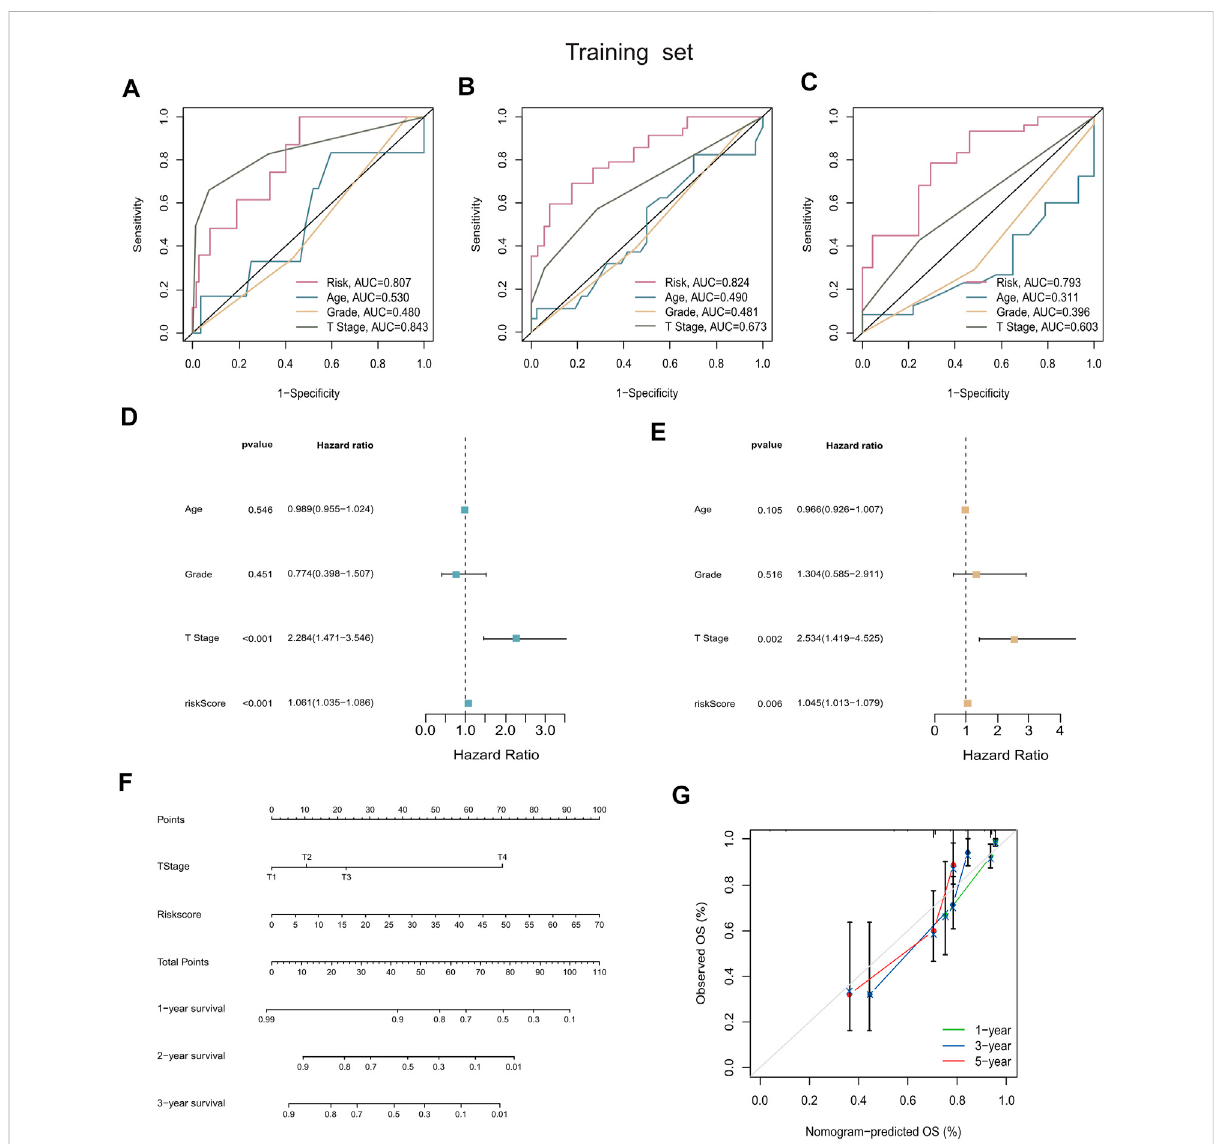
FIGURE 5 Construction and validation of the prognostic nomogram. (A – C) AUC values of nomogram points at 1-year, 3-years, and 5-years were compared with other clinical parameters, including age, grade, stage, and T stage. (D,E) Forest plots summarizing the results of univariate and multivariate Cox analyses of risk scores and clinicopathological features. (F) The nomogram was plotted based on the signature and T Stage. (G) Calibration plot for internal validation of the nomogram. Survival is depicted on the Y -axis, and nomogram-predicted survival is shown on the X -axis. Besides the dashed diagonal line, green, blue, and red lines represent the 1-year, 3-year, and 5-year observed